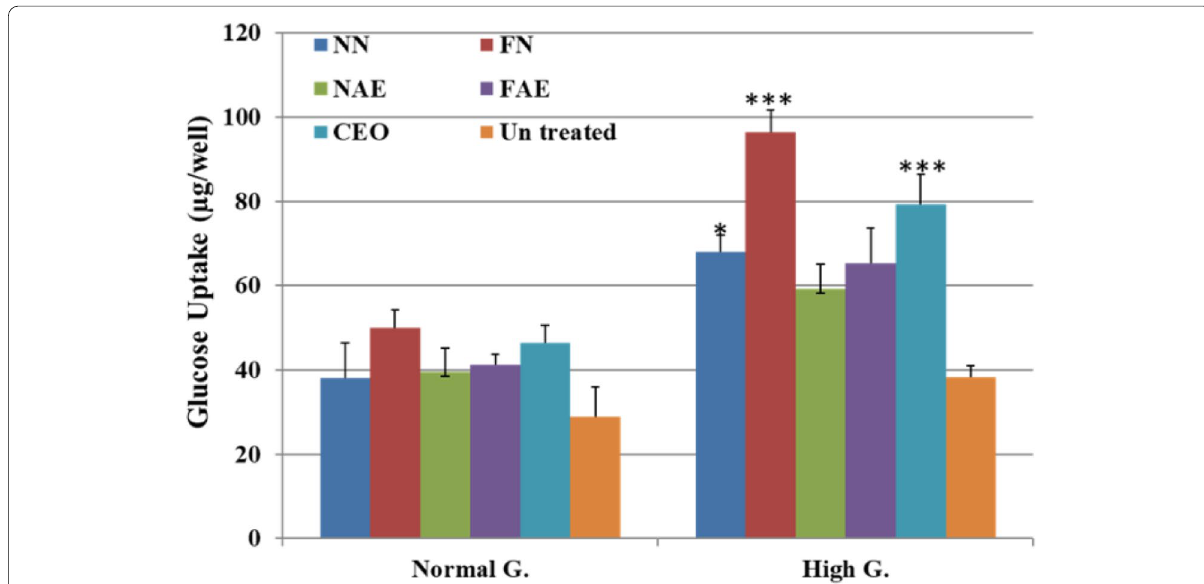
Fig. 11 The glucose absorption of samples in 0.25 mg/ml for one day by RIN-5 and L6 cells